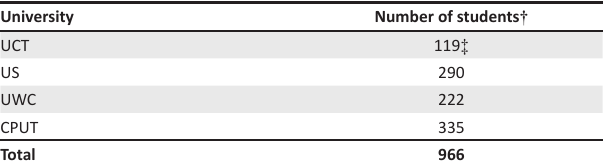
TABLE 2: Sample and